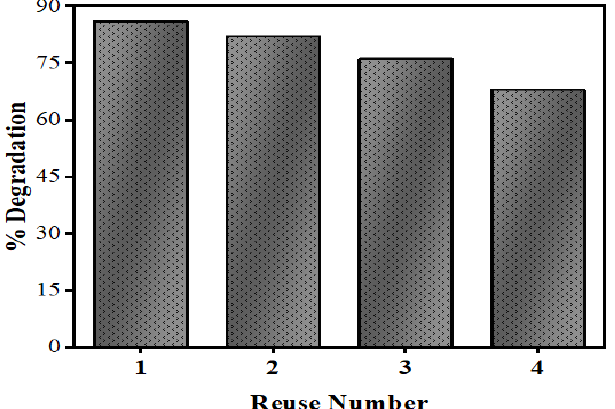
Figure 20. Reusability of Mn:ZnS QDs for NOFX degradation.